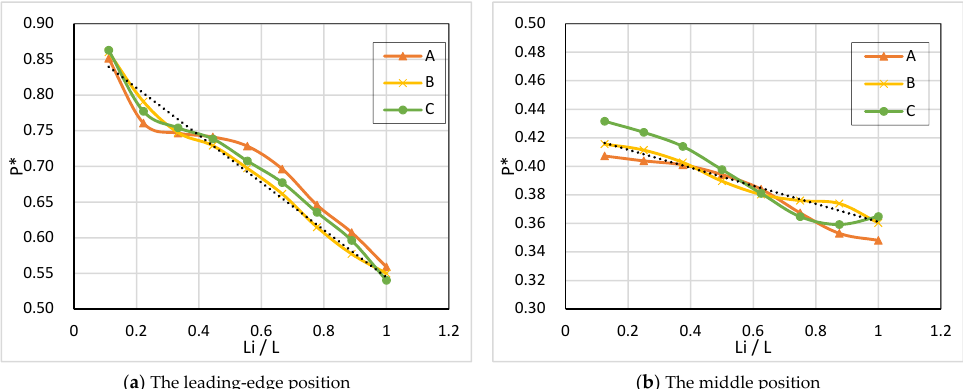
Figure 11. The circumferential pressure decreases in the rotor